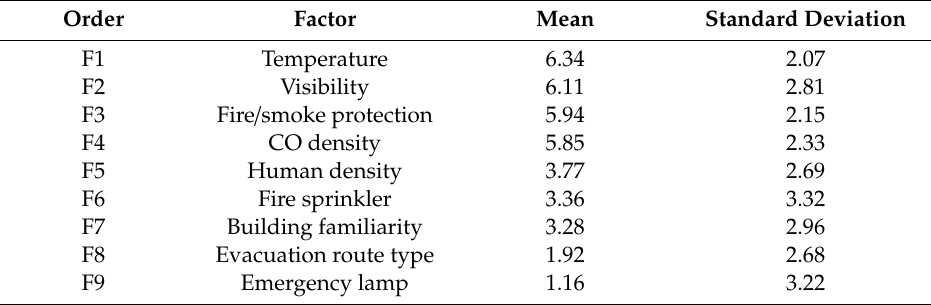
Table 4. Mean and standard deviation of all risk factors.